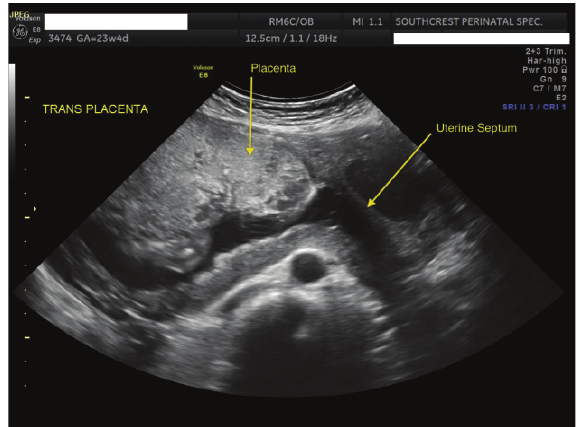
Figure 1: 23-week transverse view of septate